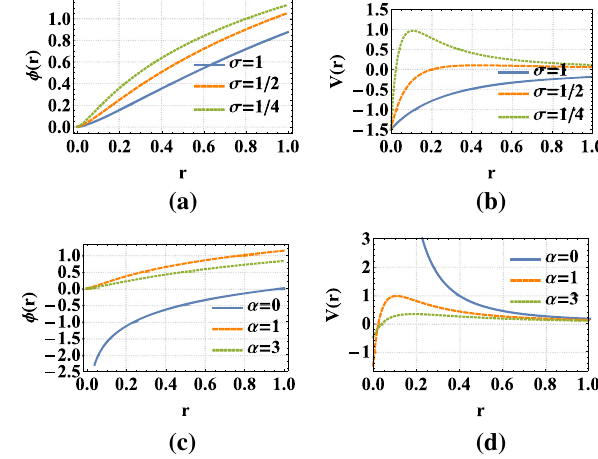
Fig. 6 The metric components (63)–(64) and the curvature scalar (70). a The metric component H ( r ) , b the solution of W ( r ) , and c the cur- vature scalar R ( r ) with α = 1. d The metric component H ( r ) , e the